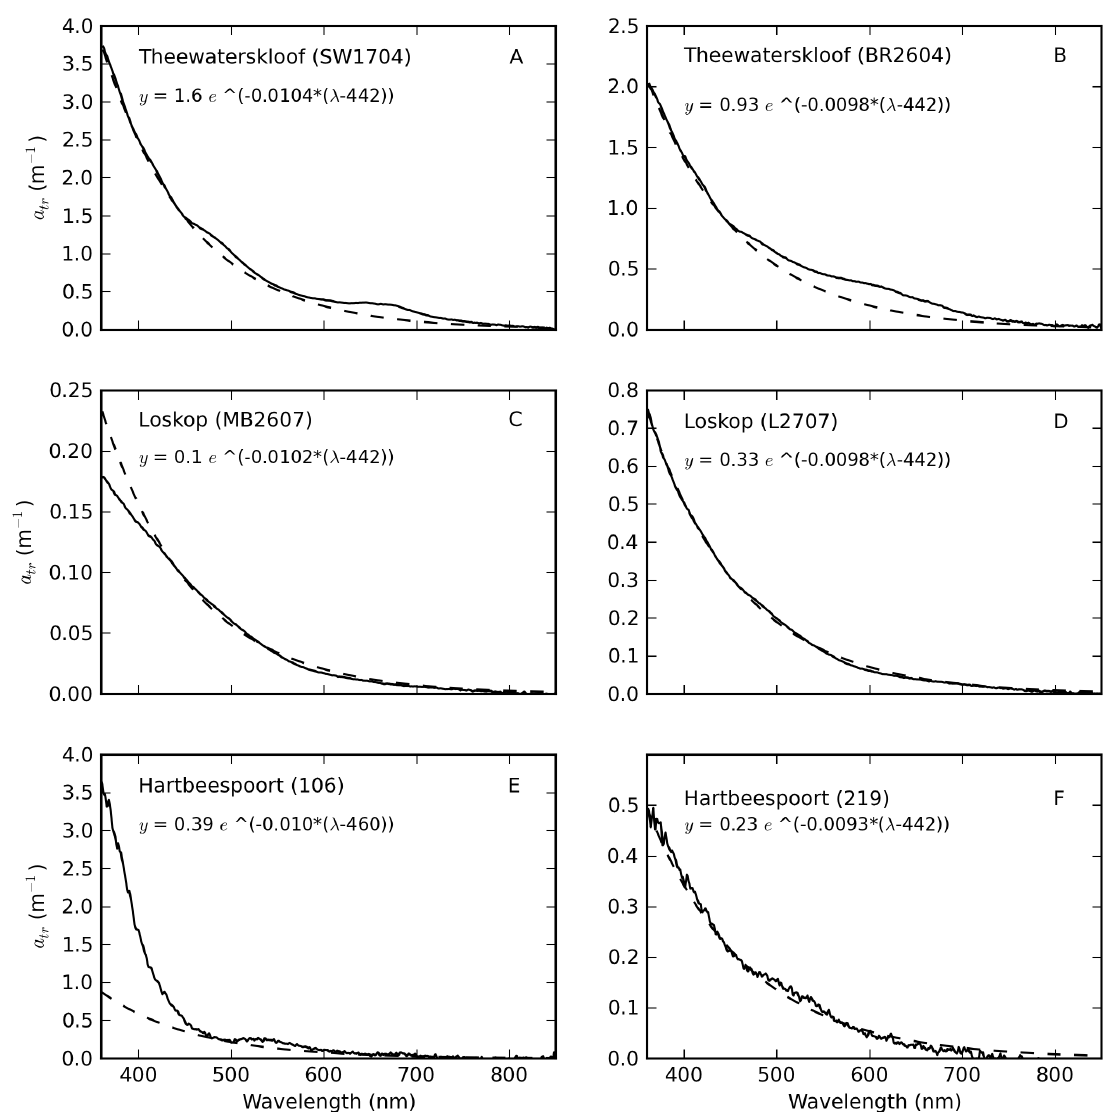
Figure 8. Selected a examples showing measured data (solid line) and the corresponding tr exponential fit (dashed line). The sample point ID is shown in